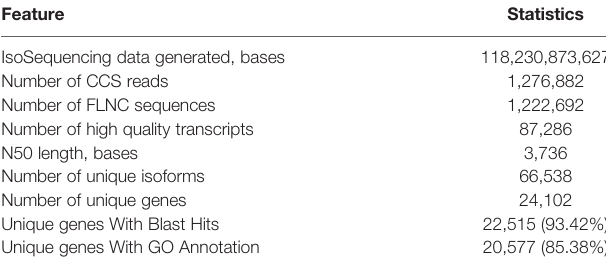
TABLE 1 | Summary of Isoform sequencing and transcriptome of M. cephalus